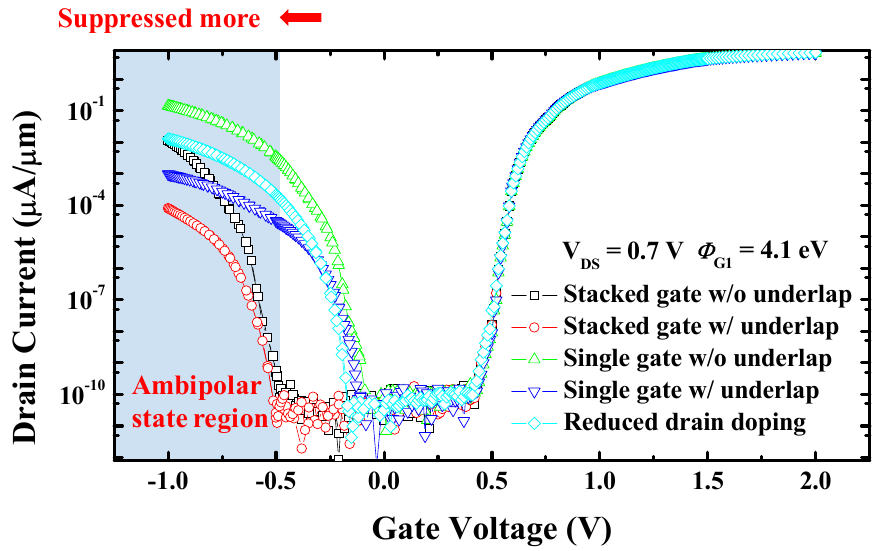
Figure 4. Transfer characteristics for stacked gate L-shaped TFET, stacked gate L-shaped TFET with underlap, low drain doping L-shaped TFET, (conventional) single gate L-shaped TFET, and single gate L-shaped TFET with underlap at V DS = 0.7 V. It is illustrated that the ambipolar state region significantly contracts in the stacked gate L-shaped TFET.